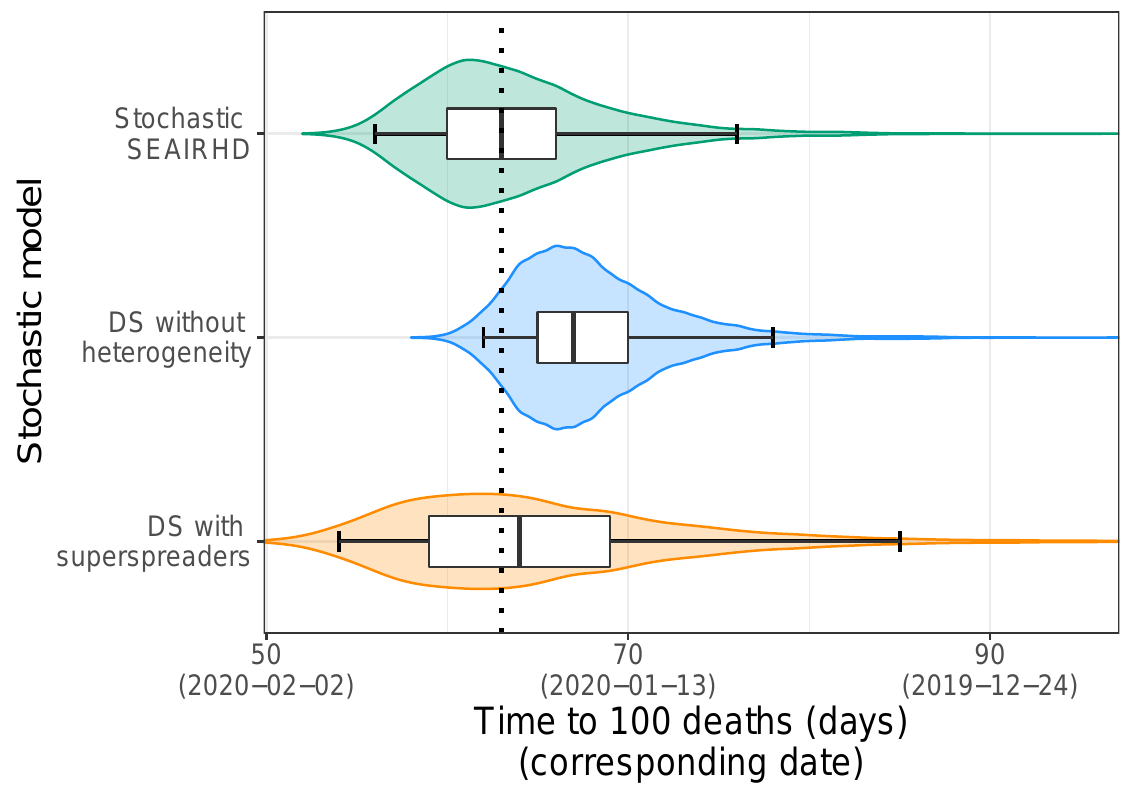
Figure 1 – Estimated distribution of the number of days until daily mortality incidence reaches 100 cases. The boxplots and the whiskers indicate the 2.5%, 25%, 50%, 75%, and 97.5% quantiles out of the 10,000 simulations. The red dashed line shows the estimates using the deterministic